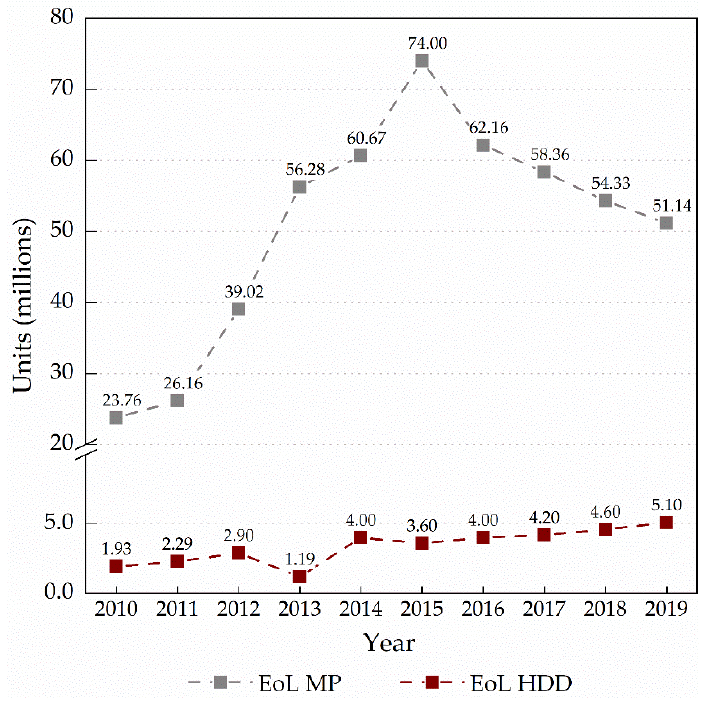
Figure 1. End-of-life generation (million units) of mobile phones (MPs) and computers (HDD) in Brazil throughout 2010–2019.